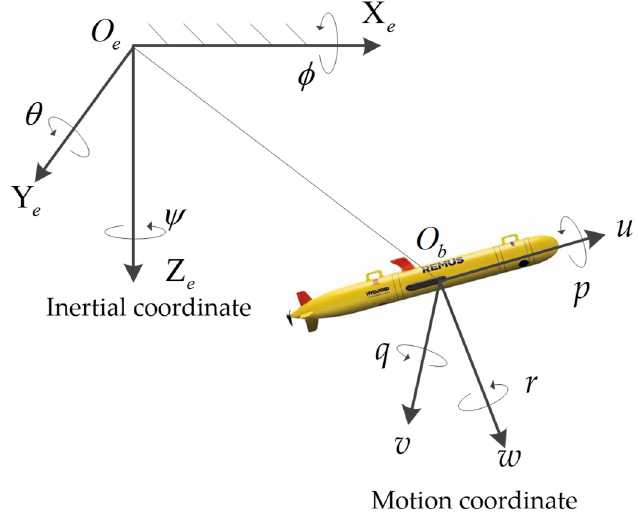
Figure 1. The inertial coordinate system and motion coordinate system of AUV.